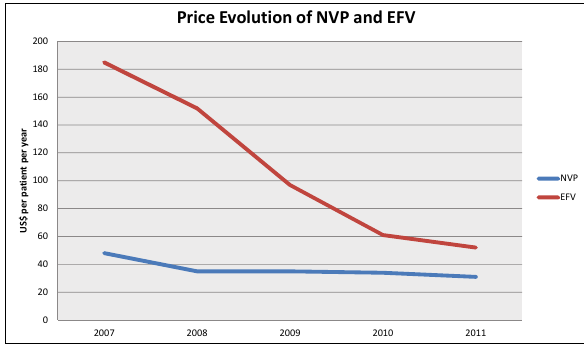
Fig. 1. Price evolution of NVP and